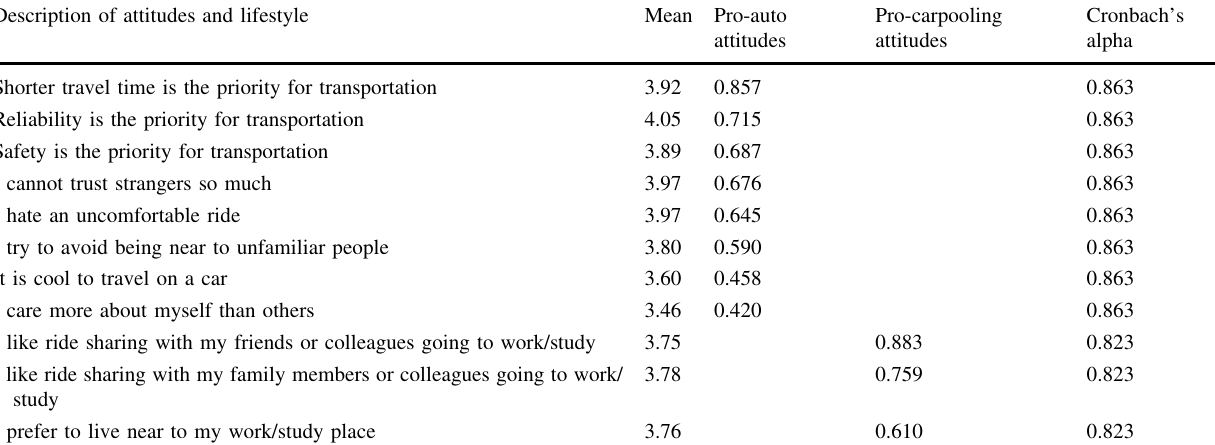
Table 5 Rotated factor loadings for lifestyle and attitudinal aspects of carpooling Description of attitudes and lifestyle